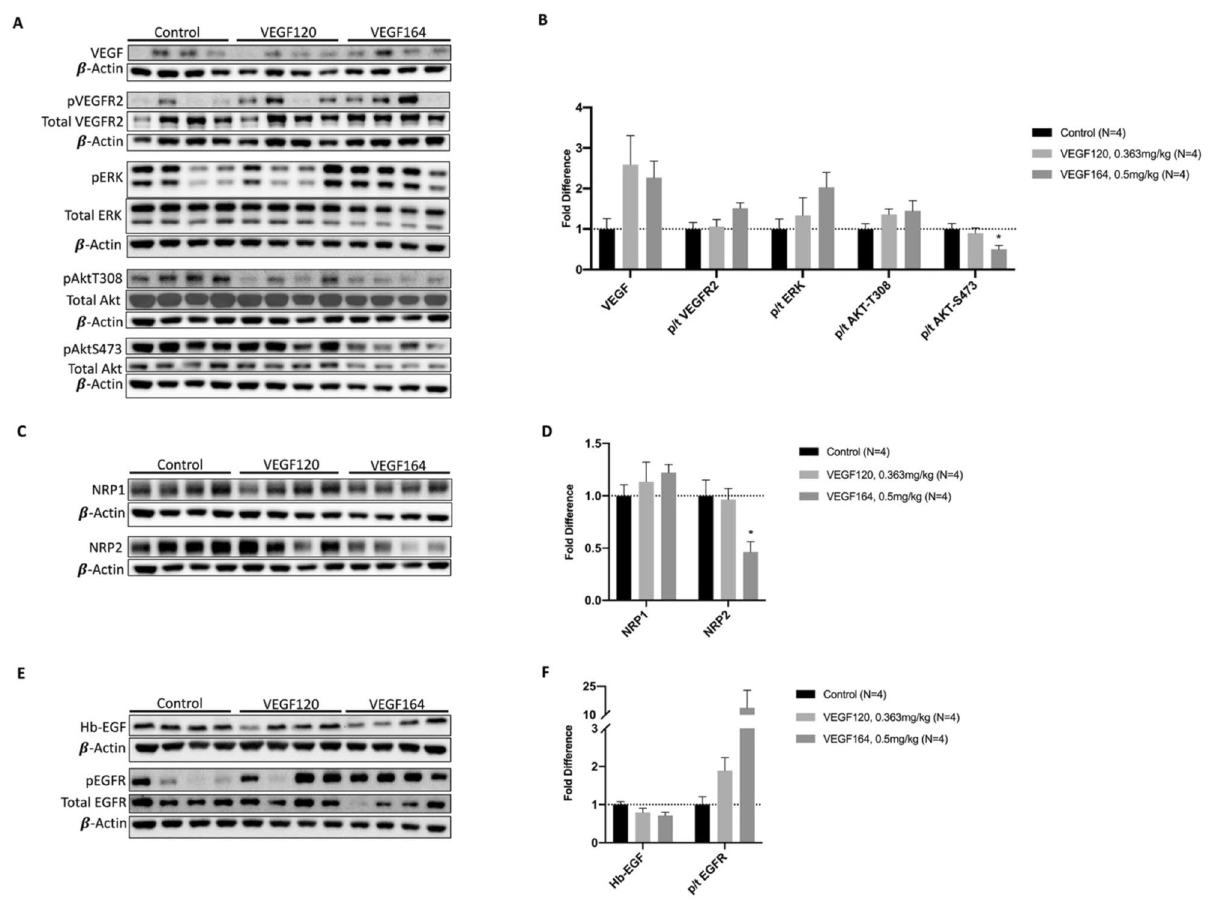
Figure 4. Lung tissue protein analysis. VEGF treatment with either VEGF120 or VEGF164 increased lung tissue expression of VEGF ligand, activated VEGFR2 (phosphorylated/total receptor), and downstream proliferation markers activated ERK (phosphorylated/total ERK), and activated AKT-T308 ( A , B ) [Full- length uncropped blots are provided in Supplementary Information File 1.] However, activated AKT-S473 was significantly downregulated. VEGF treatment also significantly downregulated co-receptor neuropilin-2 (NRP2), while co-receptor neuropilin-1 (NRP1) expression was not significantly different between groups ( C , D ). [Full-length uncropped blots are provided in Supplementary Information File 2.] While heparin-binding epithelial growth factor (Hb-EGF) expression was unchanged with treatment, activated epithelial growth factor receptor (phosphorylated/total EGF receptor) was upregulated, indicating potential paracrine signaling by VEGF treatment ( E , F ). [Full-length uncropped blots are provided in Supplementary Information File 3.] Antibodies probed on the same blot were incubated on cut membranes to facilitate specificity of binding and ability to probe multiple antibodies at one time. The β-actin loading control for each membrane is displayed below the antibodies probed on the same membrane. For membranes probed with phosphorylated and total protein, total protein antibody was used stripping the membrane as appropriate. Full length uncropped membranes are provided in the Supplementary Information Files. Statistical analysis of protein expression was performed by ANOVA with Holm-Sidak correction for multiple comparisons. Results are expressed as mean ± SE. *P < 0.05. Each lane represents lung protein lysate from a different mouse. Western blots were performed one to three times for quality control, and a representative image is quantitating the percentage of total proliferating pulmonary cells (including both endothelial and epithelial cells), VEGF164 induced a significant increase in global pulmonary cell proliferation (endothelial and epithelial cells) compared to controls (49.2 ± 8.2 vs. 20.0 ± 4.8 percent, P = 0.004), while VEGF120 did not (Fig. 5C). The VEGF heparin‑binding domain increases VEGFR2 activation. In vitro activation and induction studies were performed using human microvascular lung endothelial cells (HMVEC-L) to determine the role of the HBD in downstream VEGF and potential subsequent paracrine signaling. Increasing doses of VEGF121, the human isoform of VEGF lacking the HBD, induced a dose-dependent activation of VEGFR2, as measured by the ratio of phosphorylated (p-Y1175) to total VEGFR2 after five minutes (Fig. 6A,B, Supplemental Fig. S4A,B). However, VEGF165, which contains the HBD, stimulated VEGFR2 activation to a much higher degree than VEGF121 at a lower dose. The efficacy of both mouse and human isoforms of VEGF to activate VEGFR2 in